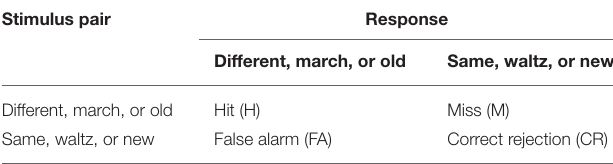
TABLE 1 | Overview of stimulus types and possible